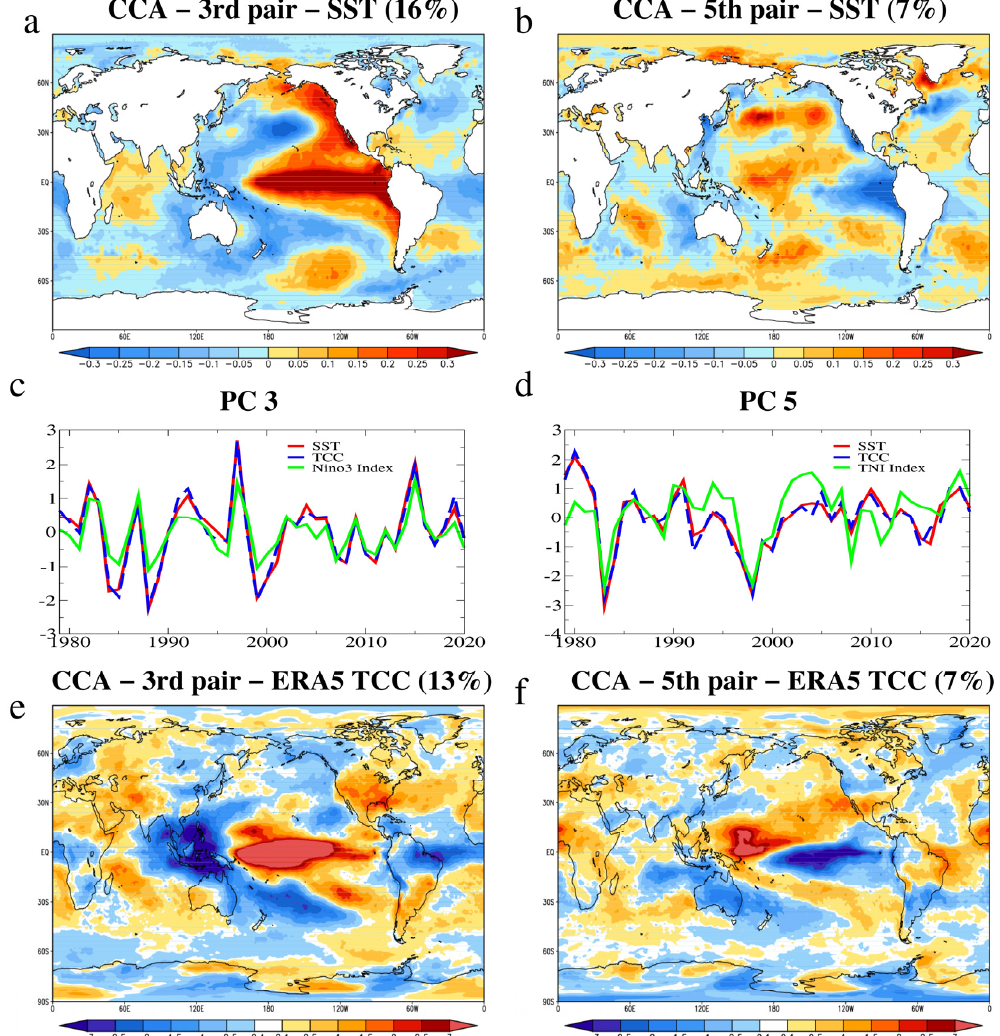
Figure 4. The EP ENSO (left) and the CP ENSO (right) footprints on global SST–TCC fields identified through CCA using ERA5 total cloud cover data on the 1979—2020 period. The left column shows the third most coupled TCC SST (°C)—TCC (%) pair identified through CCA using ERA5 TCC data, the TCC pattern ( a ), explaining 16% of variance, the SST structure ( c ), explaining 13% of variance and the time series ( e ) associated with TCC (blue line) and SST (red line). The correlation with the Niño3 index (green line) is 0.89. The right column shows the fifth most coupled SST (°C)—TCC (%) pair, the TCC pattern ( b ), explaining 7% of variance, the SST structure ( f ), explaining 7% of variance and the time series ( d ) associated with TCC (blue line) and SST (red line). The correlation with the TNI Index (green line) is 0.71.